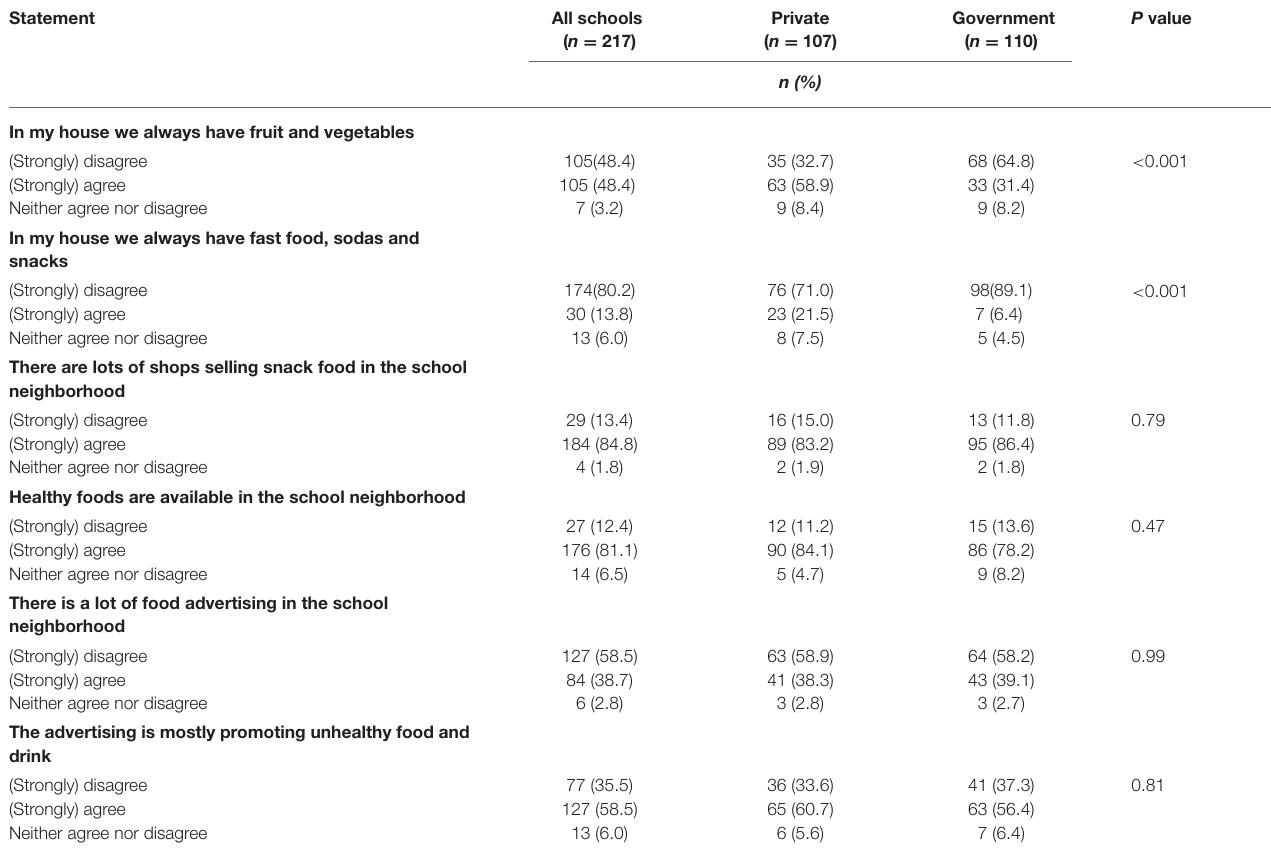
TABLE 3 | Adolescents’ perception of the school and home food